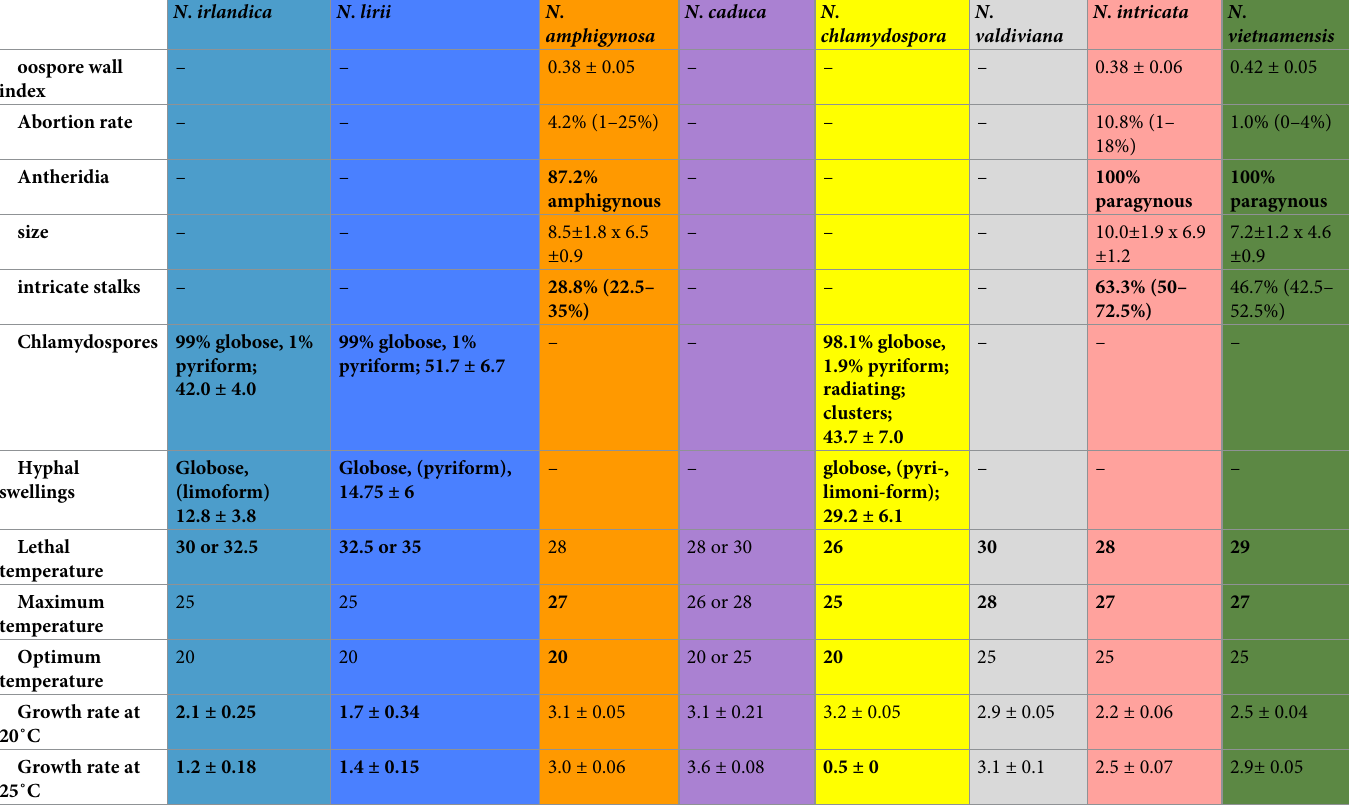
plug was formed inside the sporangiophore close to the sporangial base which averaged 2.7 ± 0.9 μ m (Fig 7A–7H, 7J and 7L). Sometimes a conspicuous double plug could be observed (Fig 7E and 7G). Sporangia were partially caducous breaking off below the basal plug (Fig 7H and 7J). Sporangial shapes ranged from ovoid or elongated ovoid (23.4%; Fig 7A–7C and 7H– 7J), ellipsoid or elongated ellipsoid (31.5%; Fig 7D, 7G and 7L) and limoniform (40.9%; Fig 7F and 7L) to obpyriform or elongated obpyriform (1%; Fig 7E). Sporangia with special features like lateral attachment of the sporangiophore (11.8%; Fig 7B), curved apex (1.0%; Fig 7G), a vacuole (1%; Fig 7A) or undulating sporangiophores (31.8%) occurred in all isolates. Sporan- gia proliferated exclusively externally, usually immediately below the old sporangium (Fig 7D, 7F, 7H and 7L). Sporangial dimensions of nine isolates averaged 43.4 ± 6.5 × 25.0 ± 2.9 μ m (overall range 27.3–65.1 × 16.3–34.8 μ m and range of isolate means 36.3–46.9 × 22.6– 27.8 μ m). The length/breadth ratio averaged 1.74 ± 0.15 with a range of isolate means of 1.6– 2.0 (Table 2). In all isolates, a few sporangia failed to form a basal septum and continued to grow at the apex (Fig 7T). Zoospores were discharged through an exit pore 5.1–14.5 μ m wide (av. 9.3 ± 1.8 μ m; Fig 7I and 7L). Zoospores were limoniform to reniform whilst